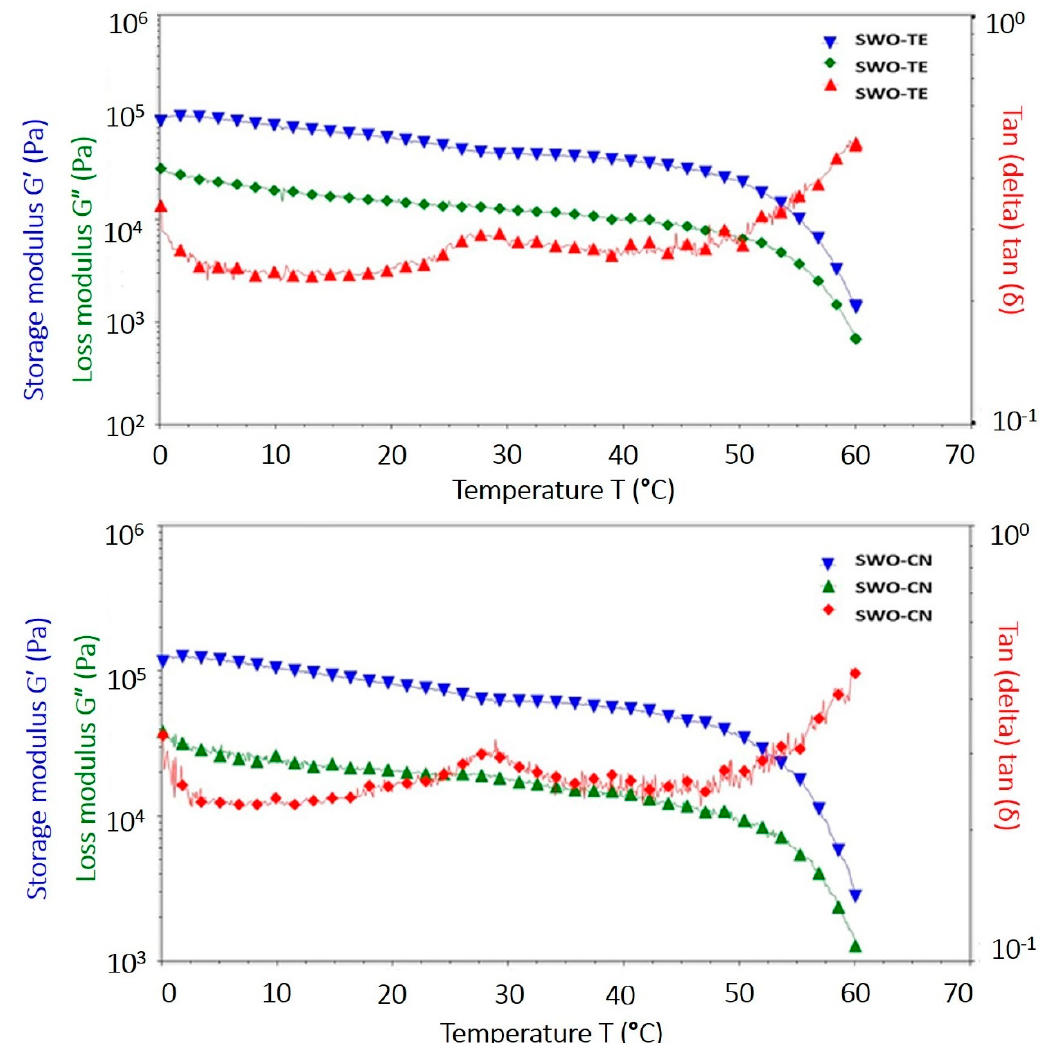
Figure 4. The temperature ramp test graphics of the oleogel samples (SWO-TE: sunflower wax oleogel with thyme, SWO-CN: sunflower wax oleogel with cumin).